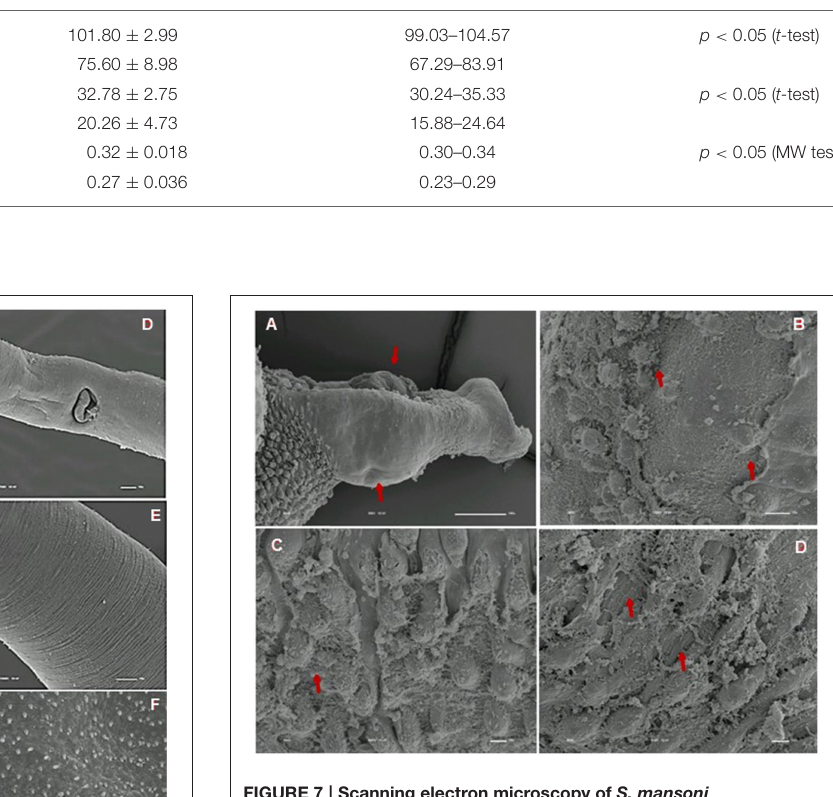
FIGURE 7 | Scanning electron microscopy of S. mansoni PZQ-susceptible strain adult males after exposure to 0.3 µ M of PZQ for 3 h. (A) Susceptible strain adult males upon exposure to PZQ, presenting changes in acetabular suckers; (B) tegument peeling; (C,D) destruction of tubercles and spines. Red arrows indicate alterations. Image marginations: (A) 300x 10 kV ________100u; (B) 1200x 10 kV ________10u; (C) 800x 10